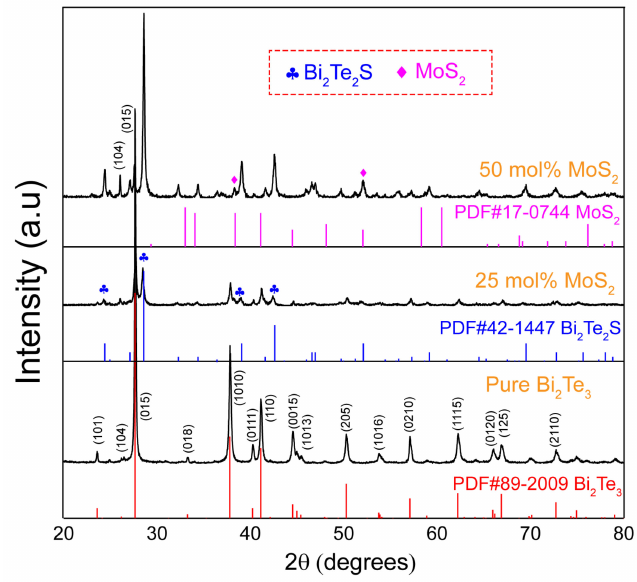
Figure 1. PXRD patterns of the Bi 2 Te 3 /X mol% MoS 2 heterostructures (X = 0, 25, 50) after